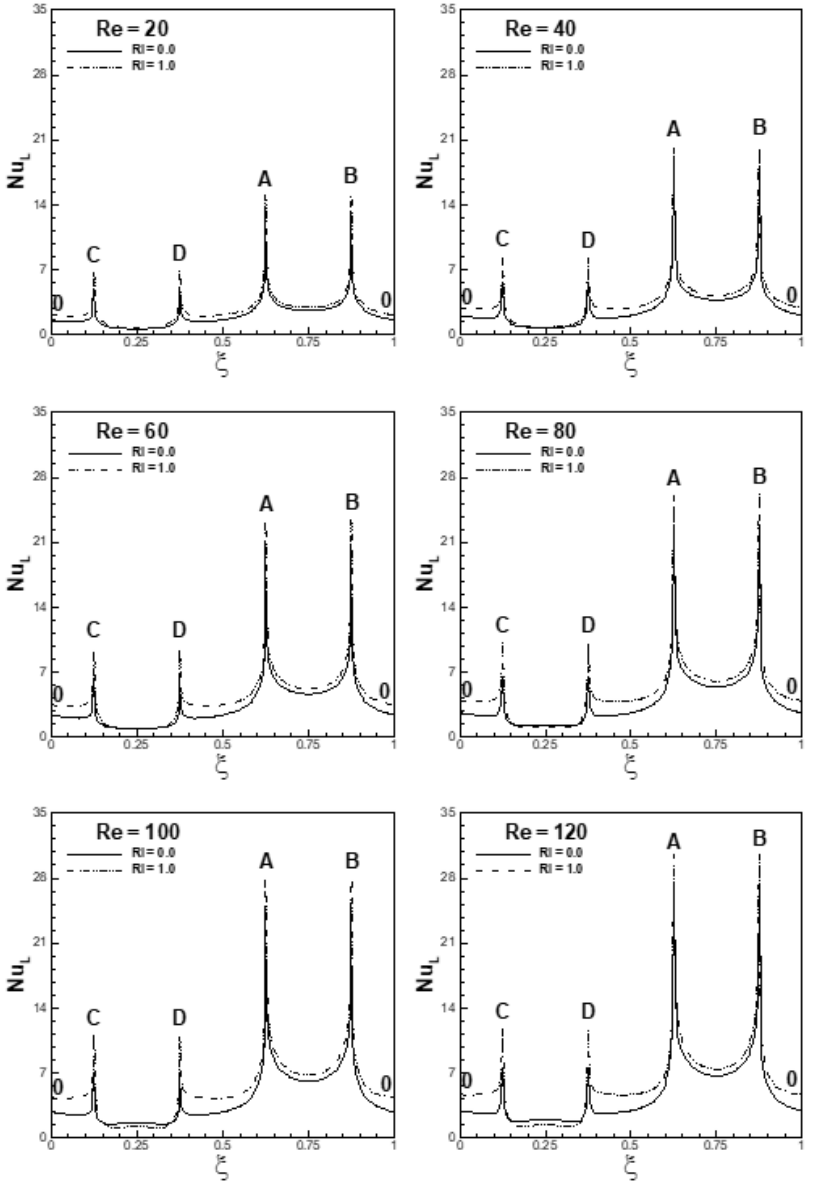
Figure 32. Variation in the local Nusselt number along the cylinder surface for the conditions (α = 0° , Ri = 0 and 1.0, 20 ≤ Re ≤ 120). Contour maps of mean/steady drag coefficient and Nusselt number , Ri on a ( R i − ) plane are depicted in Figures 34 and 35 for 20 ≤ Re ≤ 120.